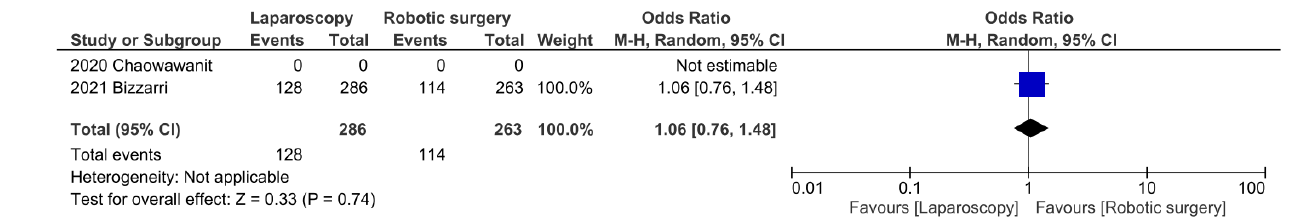
Figure 7. Forest plot of individual and pooled odds ratios, with 95% confidence interval (CI), for number of dissected SLN: 2, comparing laparoscopy and robotic surgery for SLN biopsy in EC women.